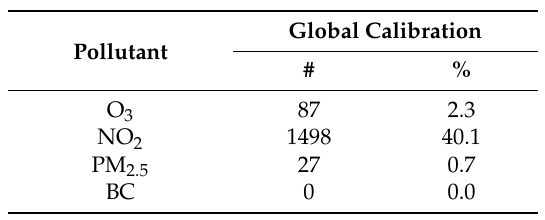
Table 6. Occurrence (numbers and proportion) of negative values in 1-min portable monitor corrected data across all periods of mobile